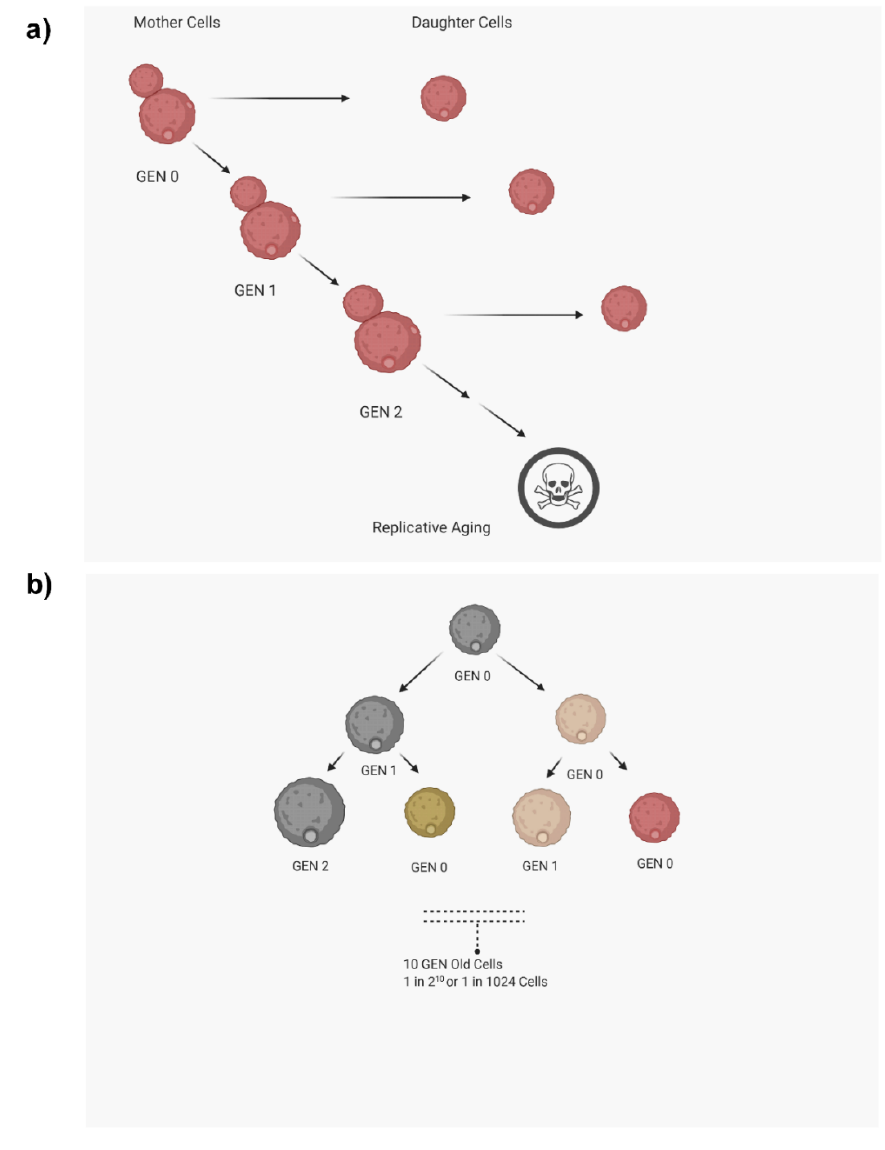
Figure 1. Replicative aging in yeast. ( a ) Mother cells undergo asymmetric cell division to produce daughter cells. A mother cell becomes one generation older each time it produces a bud. Each mother cell can produce a finite number of buds before it senesces. ( b ) In an exponentially growing culture, the number of older mother cells decreases with increasing age. The figure was drawn with the help of biorender.com.